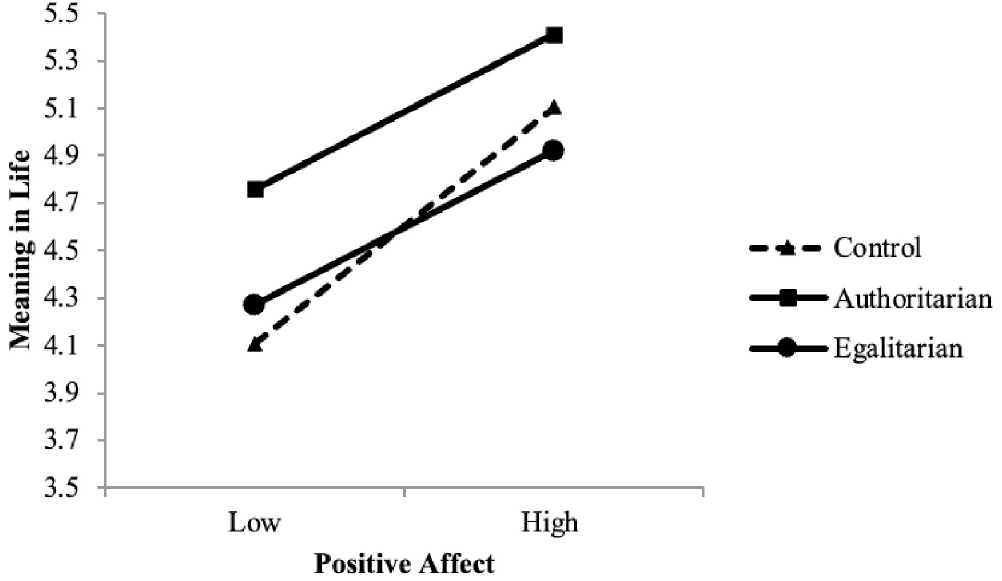
Fig 4. Predicting meaning in life from PA across conditions. Note . The slope positive affect predicting meaning in life is weaker than the slope in the control condition but does not differ from the egalitarian condition.